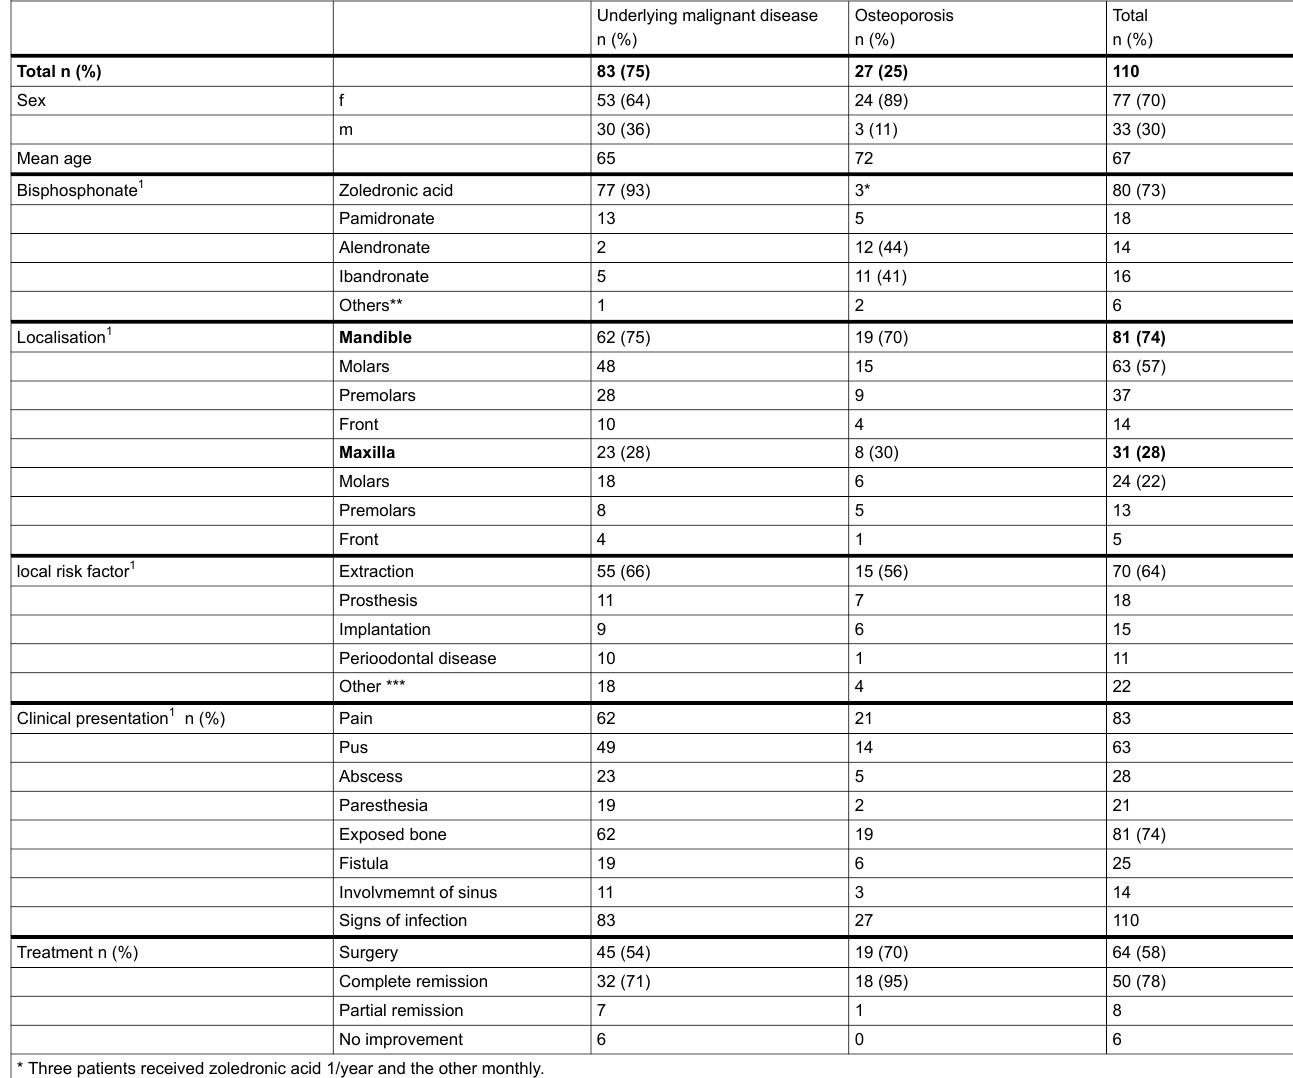
Table 1: Descriptive Statistics of study cohort, displaying gender, type of bisphosphonate localisation of osteopathology, local risk factor, clinical picture and type of treatment and outcome, respectively for patients with underlying malignant disease and